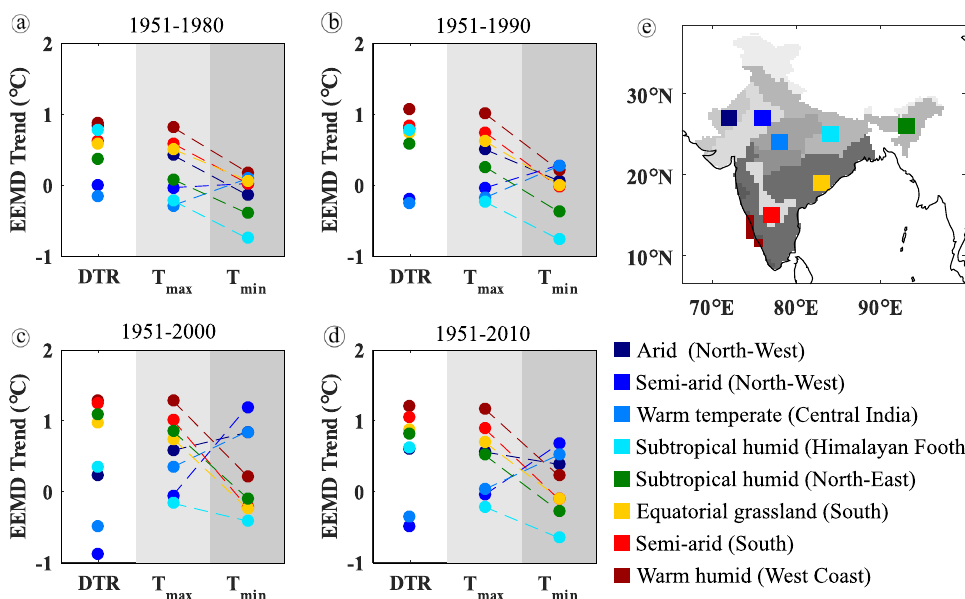
Figure 5. Regional Ensemble Empirical Mode Decomposition trend of DTR, T max and T min for heterogeneous climatic zones ( a ) 1951–1980, ( b ) 1951–1990, ( c ) 1951–2000 and ( d ) 1951–2010, ( e ) representative grids in different climatic zones. Different grey colours in India map shown in panel ‘e’ are indicative of different climatological regions of the representative grids. The maps were generated using the software MATLAB (version 2014b)